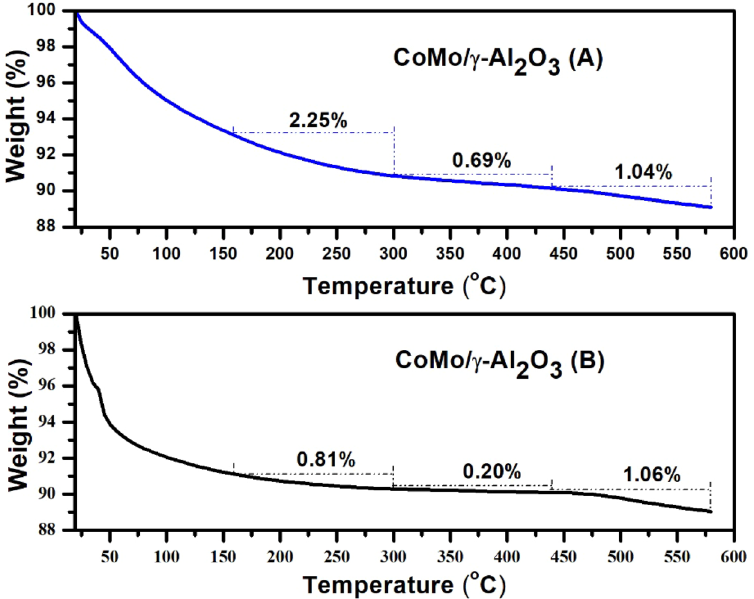
Figure 3. Temperature-programmed desorption curves of diethylamine for CoMo/γ-Al 2 O 3 catalyst before ( A ) and after ( B ) sulphidation.